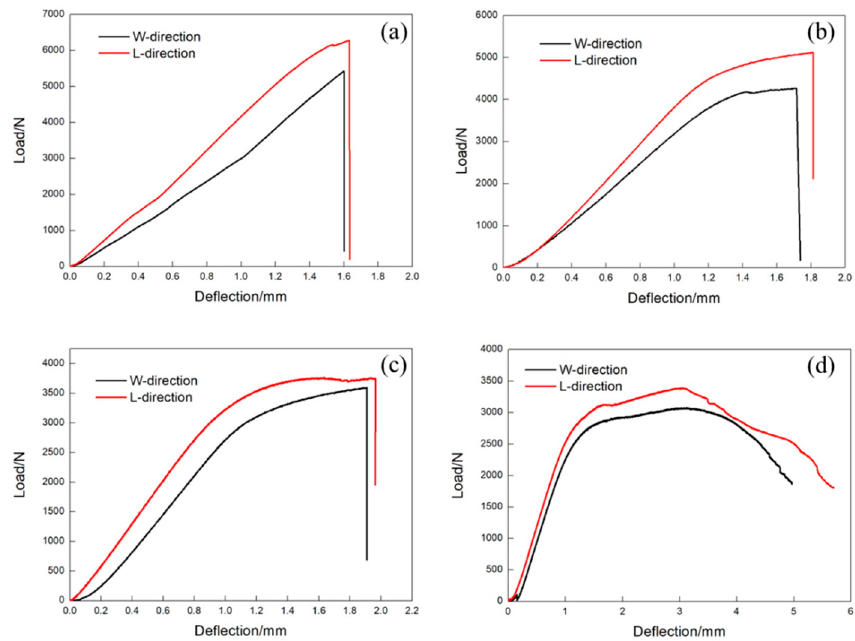
Figure 9. Typical load-deflection curves of the L-direction and W-direction sandwich panels at ( a ) 20 ◦ C,